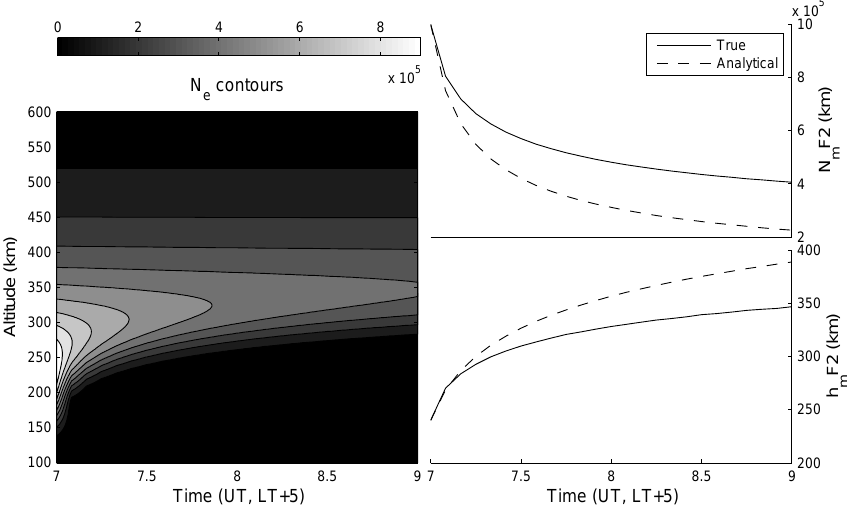
Fig. 6. Electron density as a function of time and altitude for the case of recombination only. The left panel is a contour plot of n e . The right panel is Nm F2 (top) and hm F2 (bottom). The solid lines correspond to the values using the recombination rate calculated from MSIS and the dashed lines correspond to the analytical solution of Eqs. (10) and